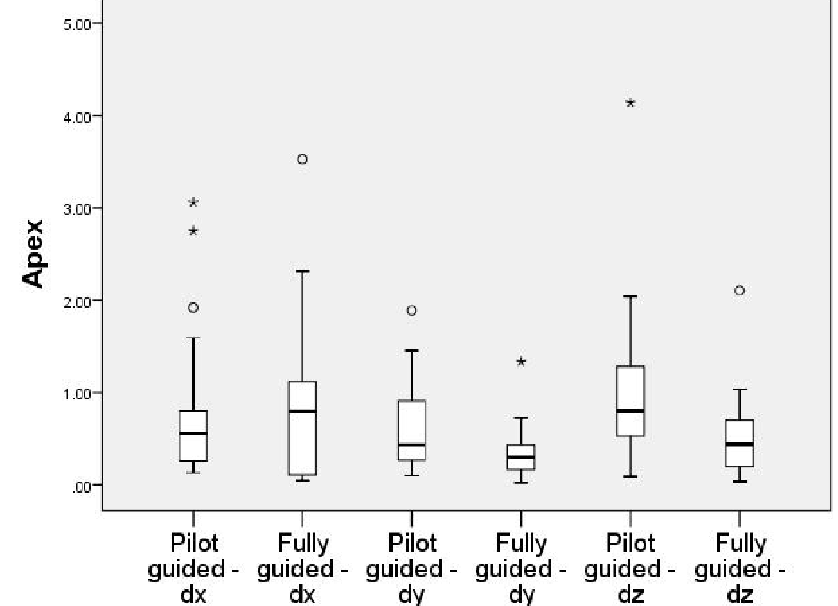
Figure 8. Box plots for deviations—apical area. (Circle and asterisk representing outlier(values that do not fall in the whisker bars) and extreme outlier(values more than three times the height of the boxes), respectively.).